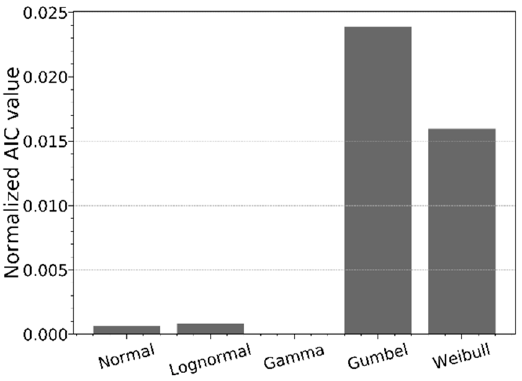
Figure 13. AIC values of the competing models.